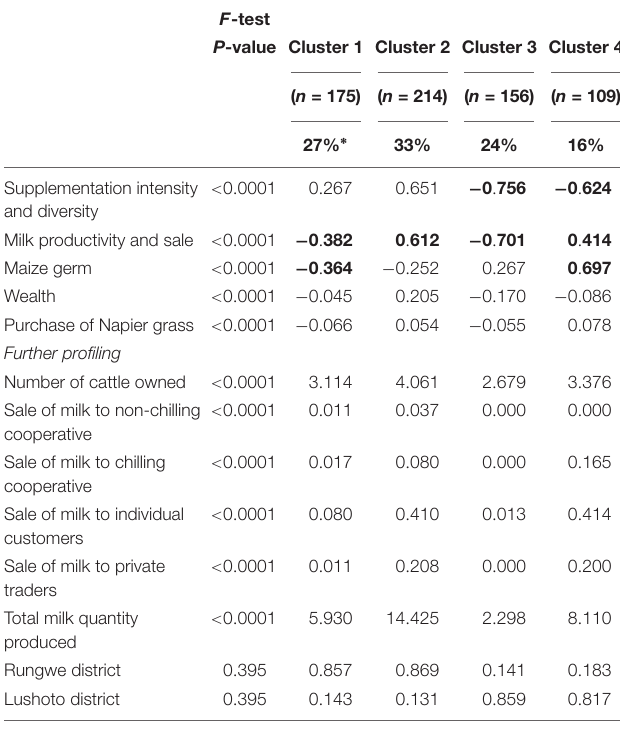
TABLE 3 | Factor loadings for various production system variables used to define management clusters.